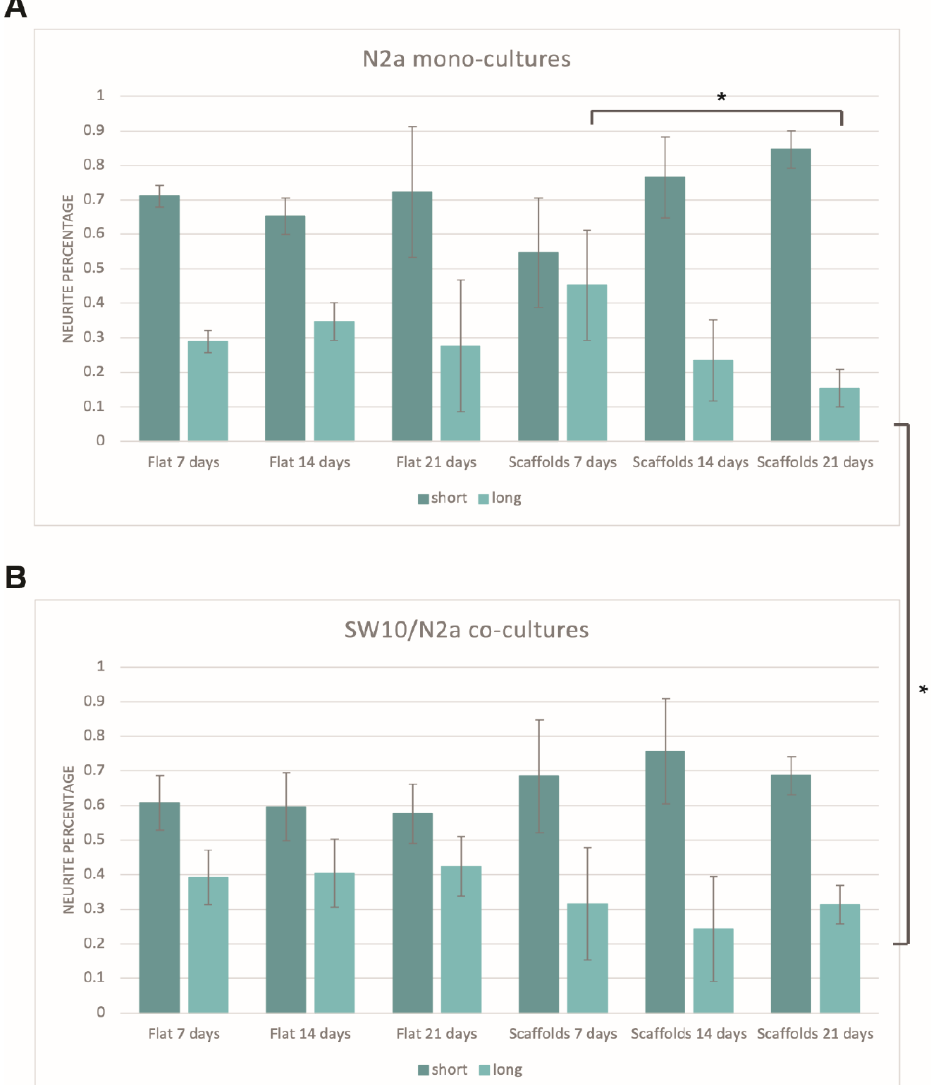
Figure 5. N2a differentiation. A, B: Percentage of short (dark green) and long (light green) neurites for mono- ( A ) and co- ( B ) cultures. Short neurites: Up to 40 μm, Long neurites: Above 40 μm. For flat controls, short and long neurite populations are relatively stable for both mono- and co-cultures. In the case of mono-cultures on scaffolds, long axons decrease in number over time, which is alleviated in the respective co-culture cases ( n = 3). (* p <